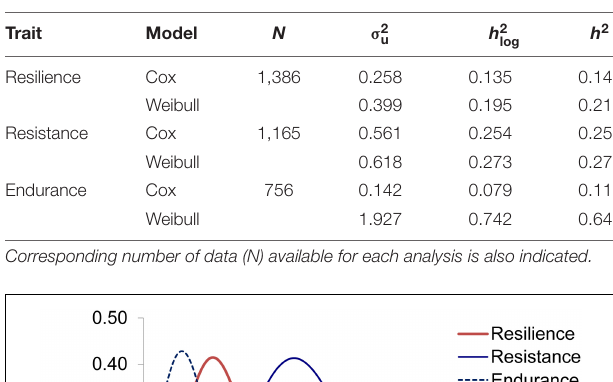
TABLE 3 | Estimates of additive genetic variance ( σ 2 u ) and heritability in the logarithmic ( h 2 log ), and original scale ( h 2 ) derived from survival analyses under Cox and Weibull models